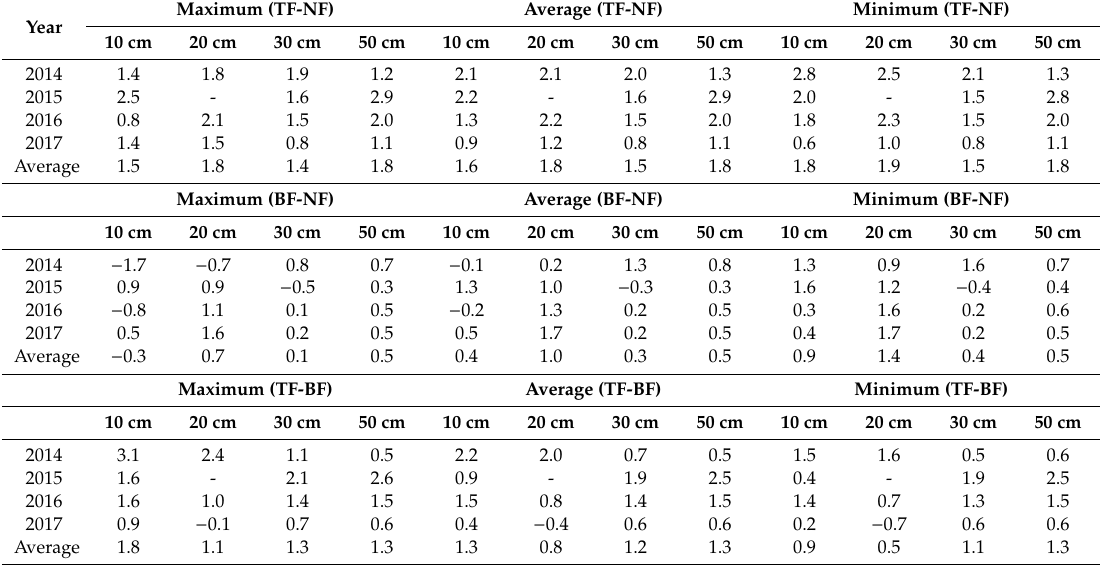
Table 3. The soil temperature (T) (daily maximum T, daily average T, and daily minimum T) di ff erences between di ff erent treatments: black film (BF), no film (NF), and transparent film (TF) at 10–50 cm soil depths in the whole growth season in